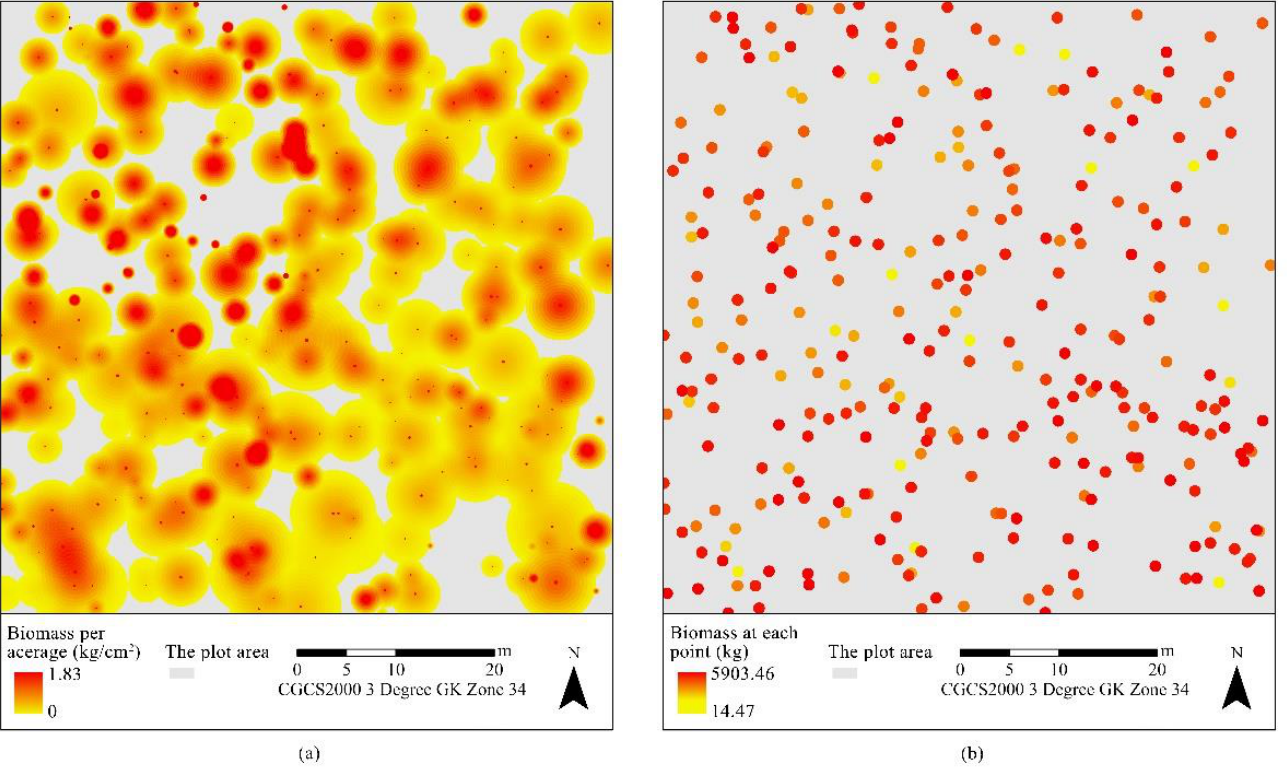
Figure 5. The AGB distributions in the plot simulated by different distribution models of biomass. ( a ) Simulated by HDM; and ( b ) simulated by LDM.